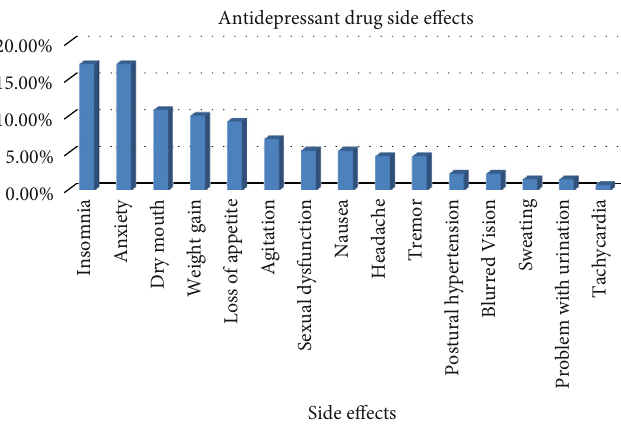
Figure 1: Frequency of patient-reported antidepressant drug side e ff ects ( n = 129 ). Table 4: Severity of side e ff ects and probability of ADRs ( n = 129 ). Variables n (%) Severity